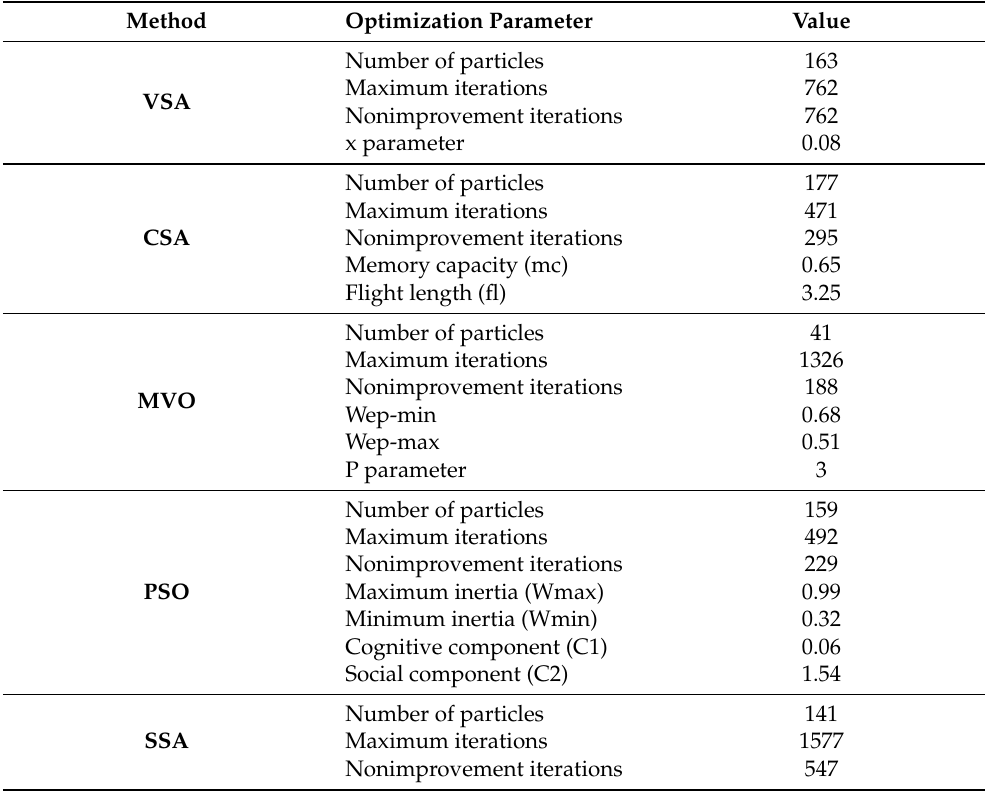
Table 8. Optimization parameters used for all solution